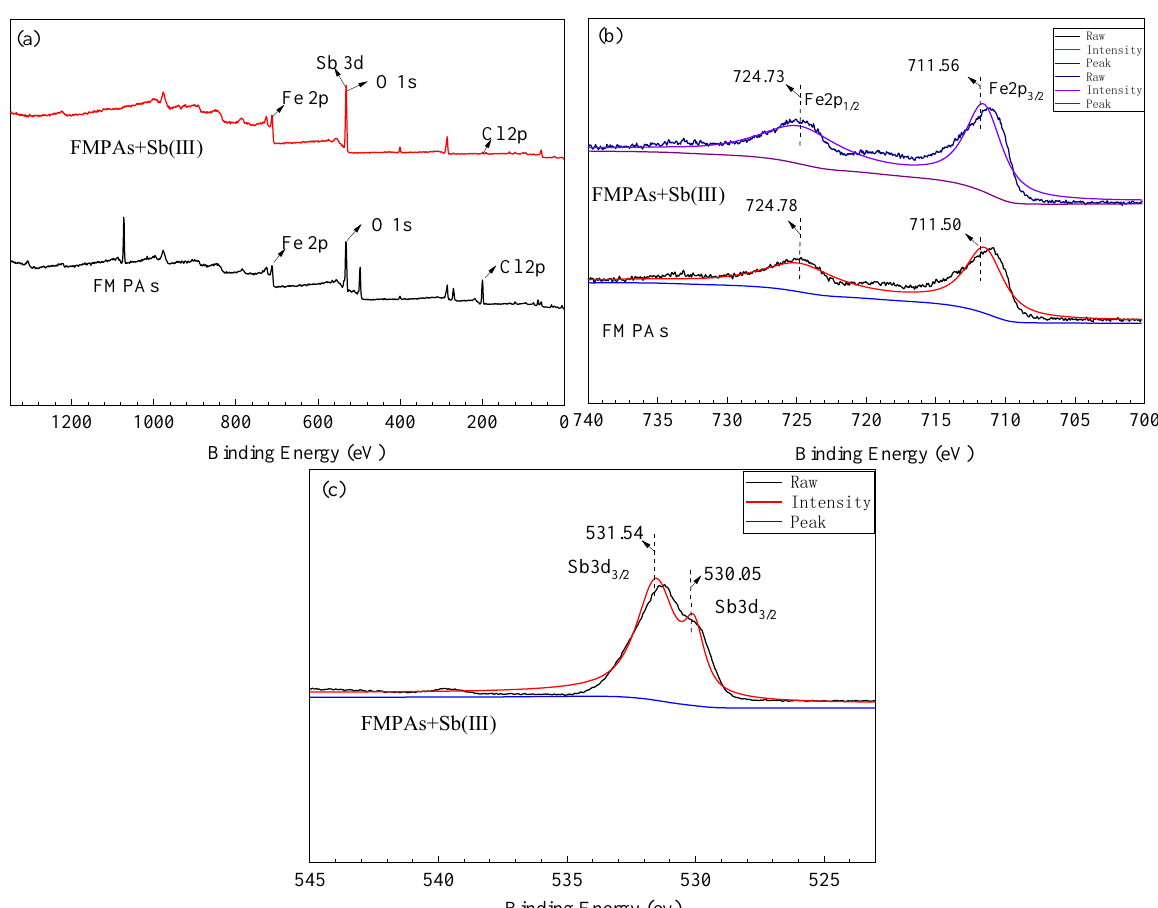
Figure 5. The XPS scan spectra of before and after adsorption by FMPAs. (( a ) The XPS full scan, ( b ) XPS spectra of Fe2p, ( c ) XPS spectra of Sb3d).